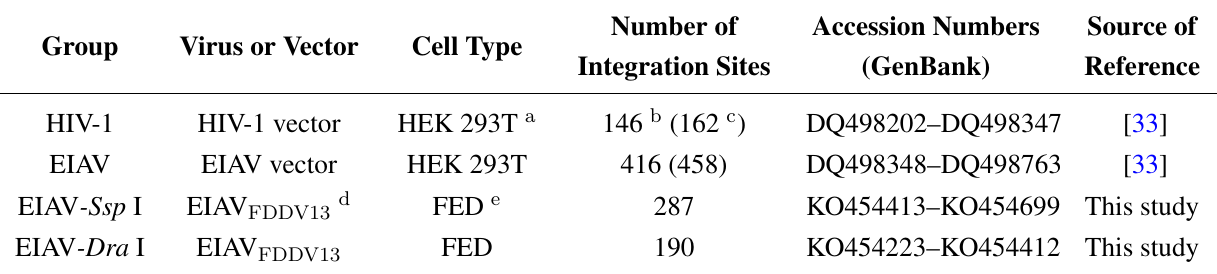
Table 1. Datasets for the integration sites used in this